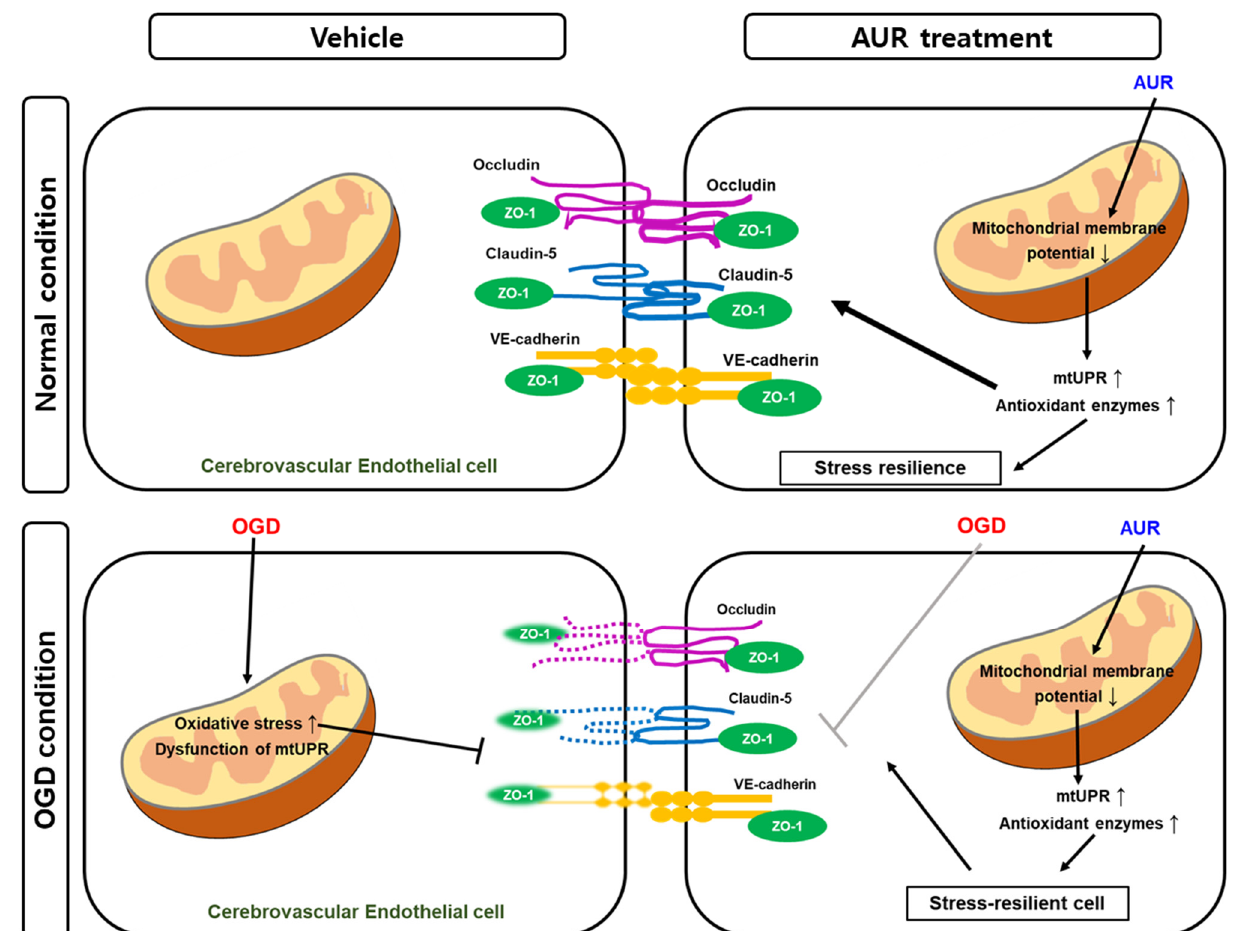
Figure 5. Schematic representation of the effect of AUR in normal condition and the protective mechanism in vitro ischemic injury model. AUR treatment can enhance junction assembly and induce resilience to oxidative stress in cerebrovascular endothelial cells by altering levels of mtUPR and antioxidant enzymes, resulting in low mitochondrial membrane potential. This reaction contributes mitochondrial stress resilience and it exhibits by alleviating degradation of junctional proteins when the cerebrovascular endothelial cells were put in OGD condition, in vitro ischemic injury model.